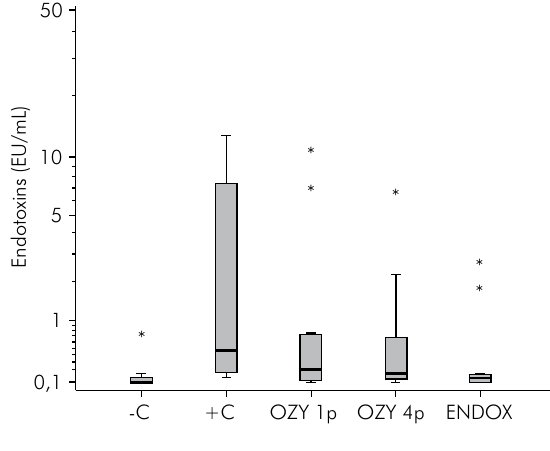
Figure 2. Boxplot distribution of endotoxin concentration in EU/mL for each experimental